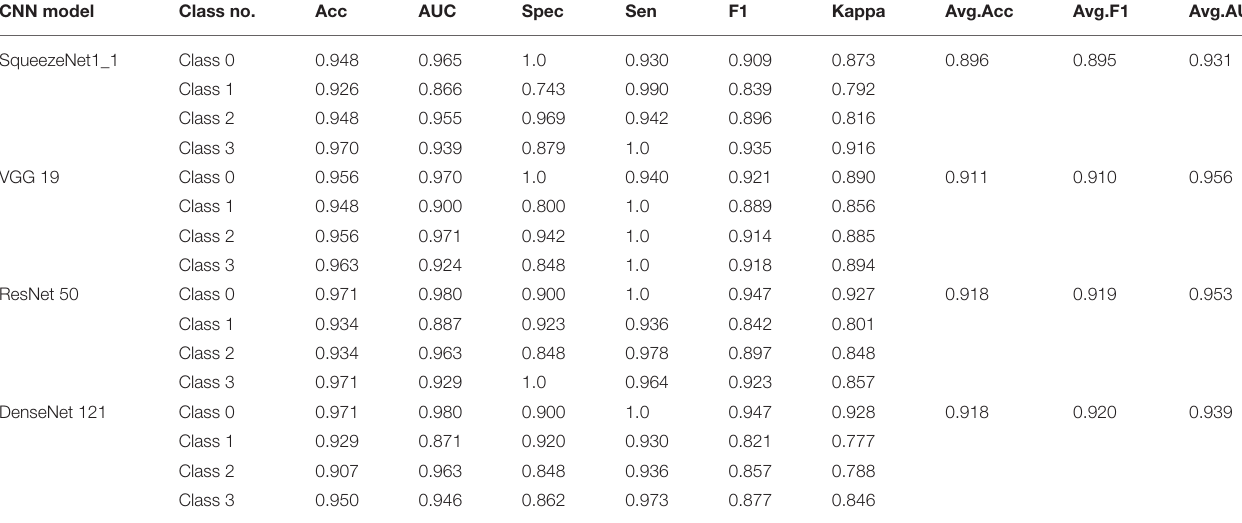
TABLE 4 | Results of multimodal fusion. CNN model